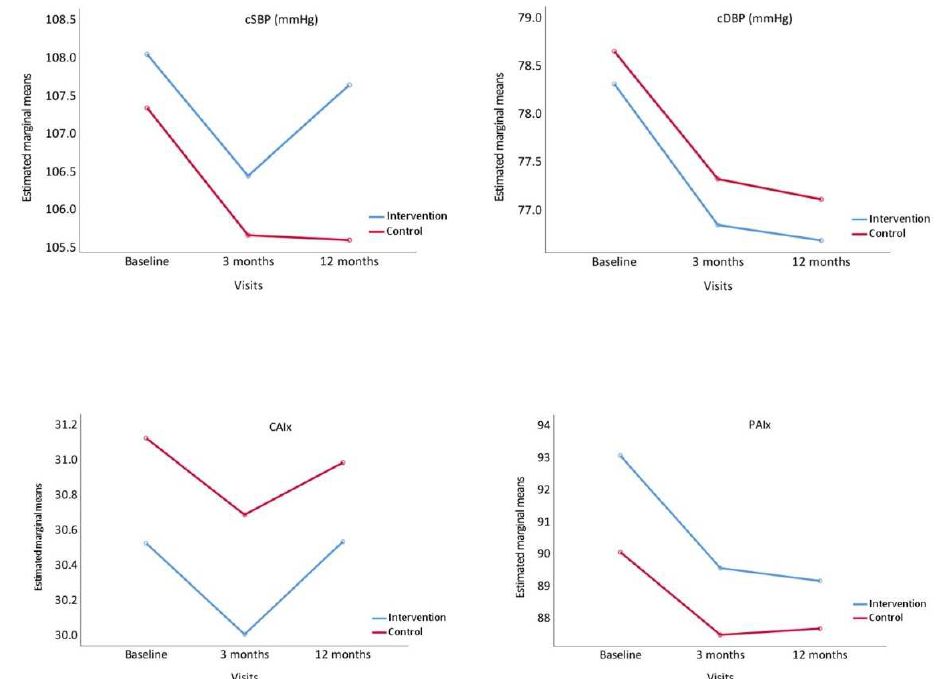
Figure 3. Evolution of central systolic blood pressure (cSBP), central diastolic blood pressure (cDBP), Central Augmentation Index, (CAIx) and Peripheral Augmentation Index (PAIx), from baseline to 3 and 12 months comparing the intervention and control groups. p value between groups: cSBP, p = 0.493; cDBP, p = 0.737, CAIx, p = 0.691 and PAIx, p = 0.375.